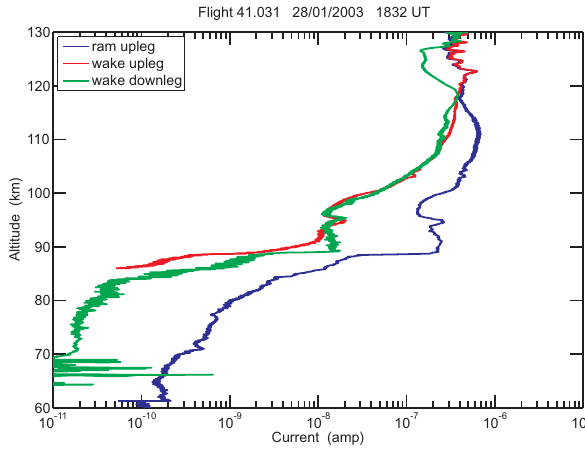
Fig. 15. Comparison of electron and positive ion Langmuir probe currents during the downleg portion of Flight 41.033 (5 July 2002, 00:47 UT).